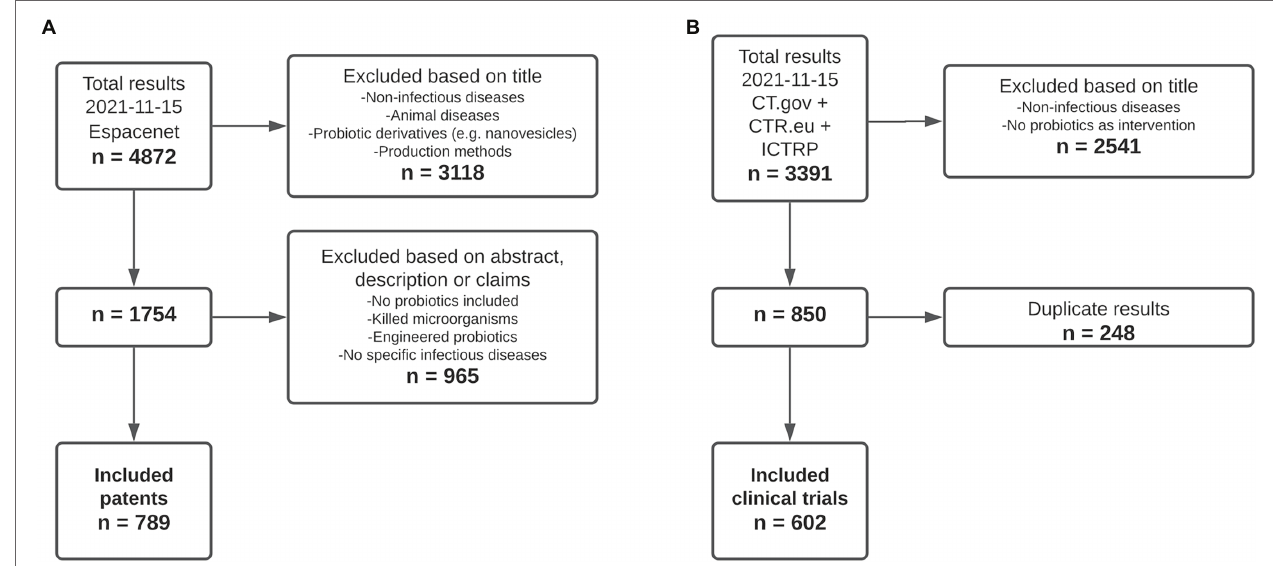
FIGURE 1 | A total of 789 patents and 602 clinical trials were included for analysis. (A) Patents. n = number of results retrieved from Espacenet. (B) Clinical trials. n = number of results retrieved from ClinicalTrials.gov (CT.gov), ClinicalTrialsRegister.eu (CTR.eu), and the International Clinical Trials Registry Platform